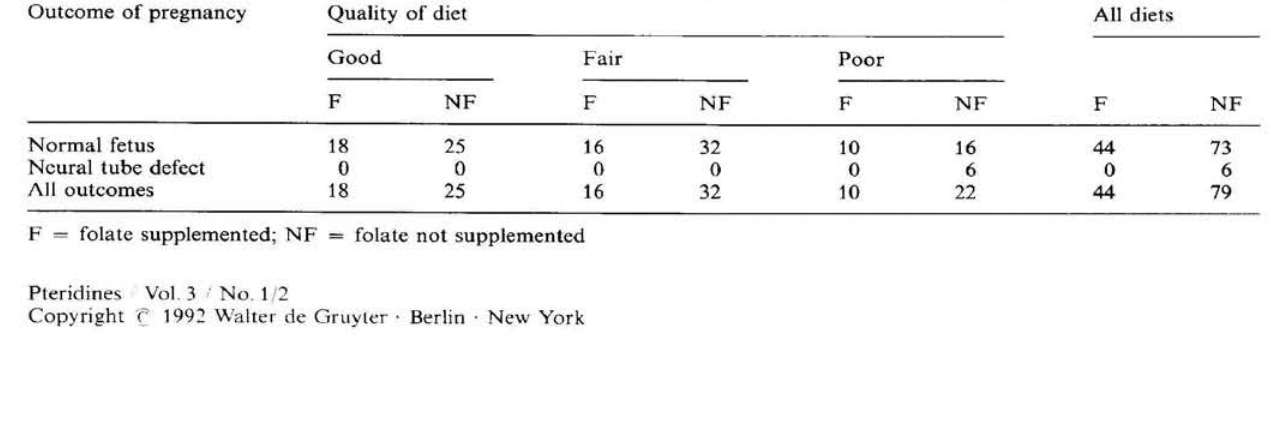
Table 1. Folic acid supplementation. Outcome of pregnancy by quality of diet in first trimester; by folate supplementation received. Outcome of pregnancy Quality of diet All diets